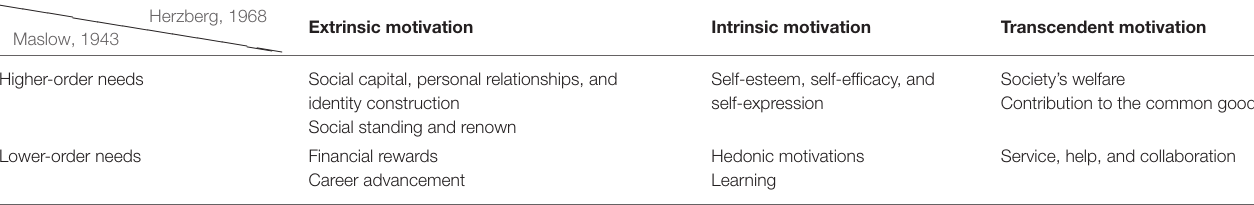
TABLE 4 | Extended integrative revision of classical motivational taxonomies and co-creation